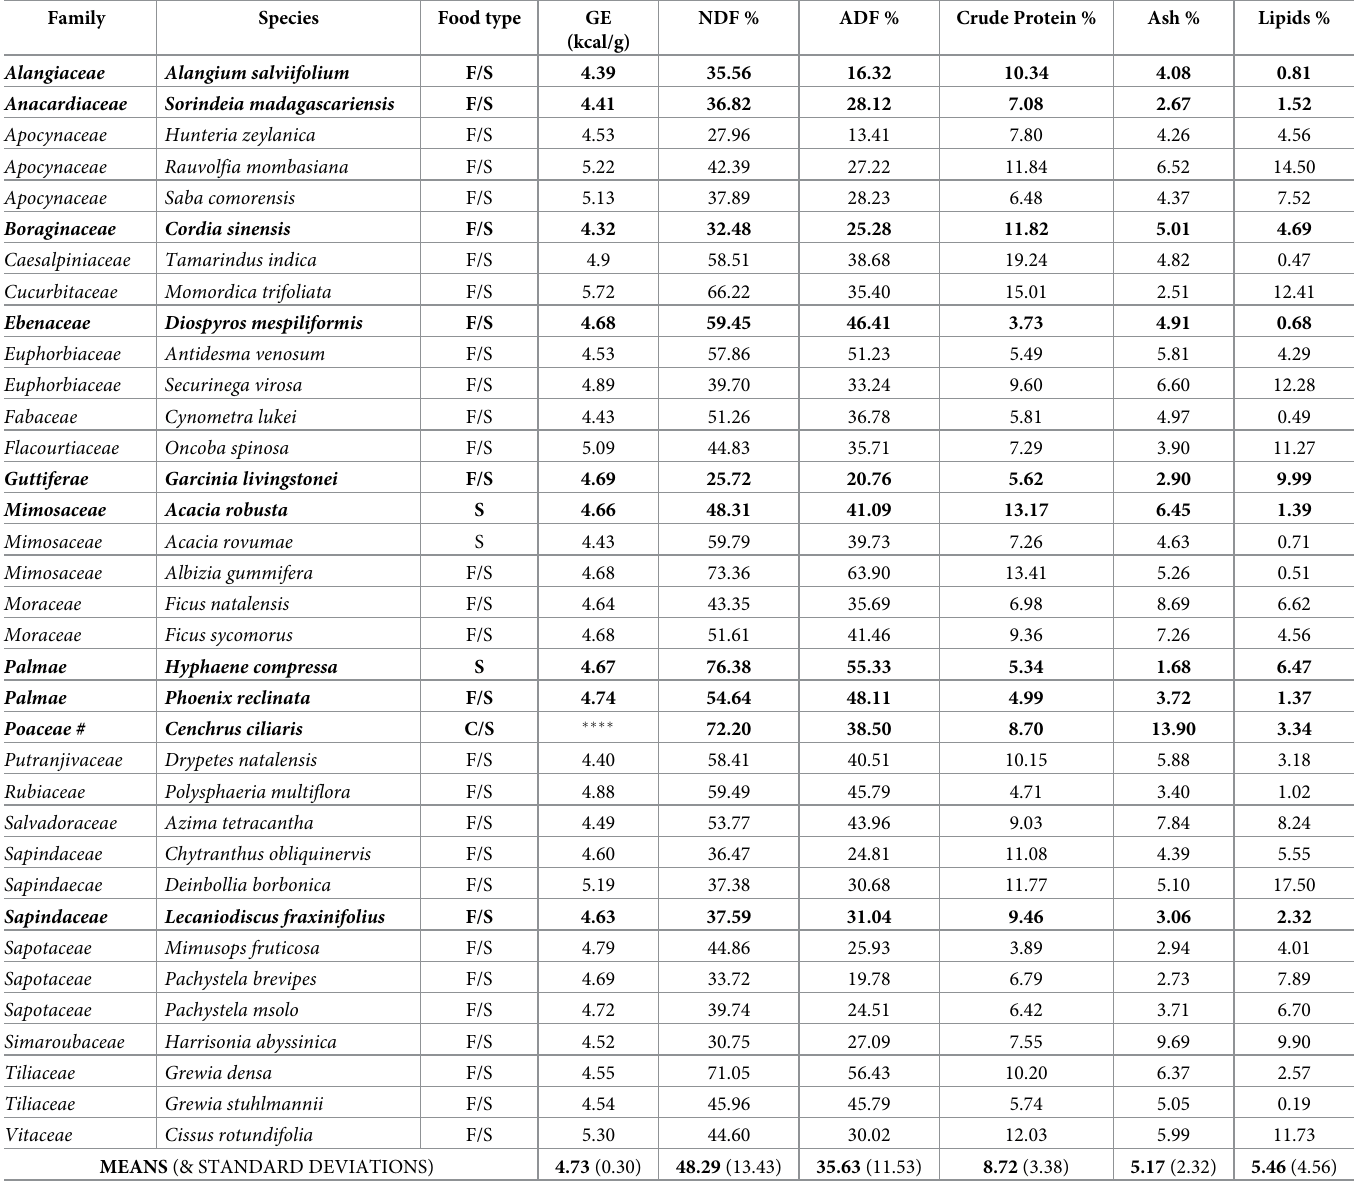
Table 1. Mchelelo baboon dietary macronutrient content (%DM)–forest samples (all).